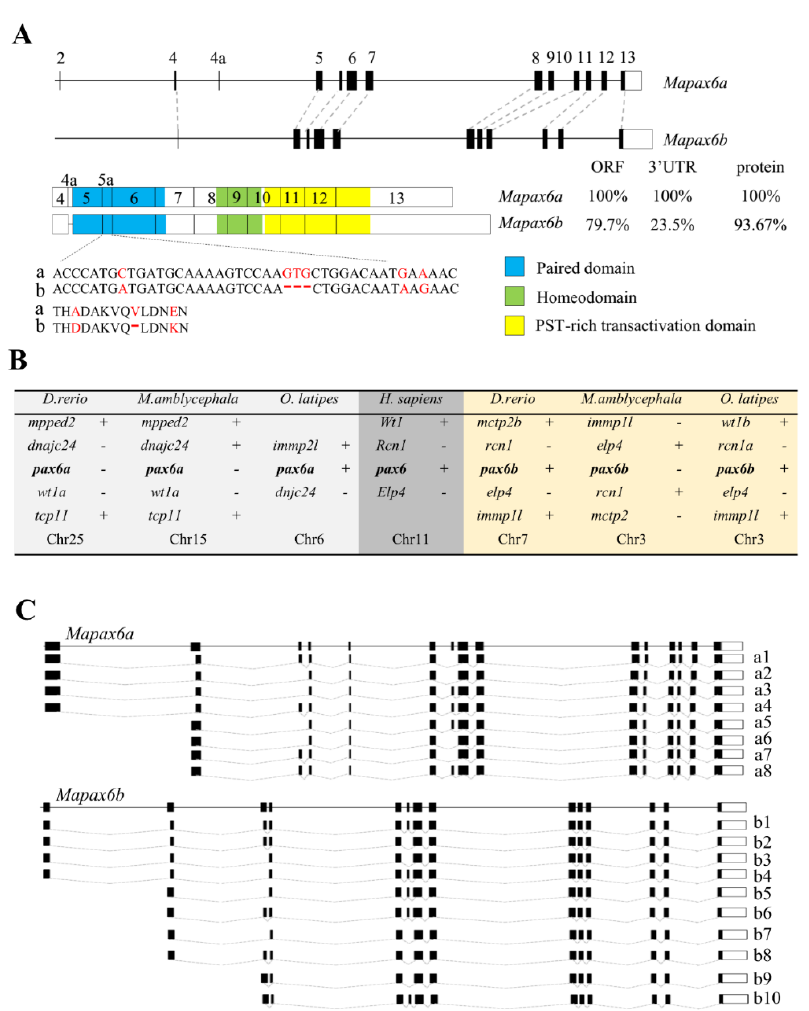
Figure 1. Comparison of the two pax6 genes of Megalobrama amblycephala . ( A ) The genomic structures of Mapax6a and Mapax6b are shown. Conserved exons were connected by dotted lines. Both the translation-start sites (ATG) of Mapax6a and Mapax6b are located in exon 4. The mRNA structure is under the genomic structure. The paired domain is stained in blue, the green area is the homeodomain, and the yellow represents the proline–serine–threonine (PST)-rich transactivation domain. The comparison percentages of the open reading frame (ORF), 3 ′ untranslated region (UTR), and protein between Mapax6a and Mapax6b were analyzed by DNAMAN software. An alignment of the nucleic acid and amino acid sequence of exon 5a is under the mRNA structure (a/b). ( B ). Synteny conservation of pax6 and adjacent genes in different species. The duplicated pax6s are indicated in medaka and zebrafish. +: forward direction; -: reverse direction. ( C ) Summary isoforms of Mapax6a and Mapax6b . RNA-seq detected all of these isoforms, which were produced from alternative exons such as exon 2, exon3, and exon 5a.